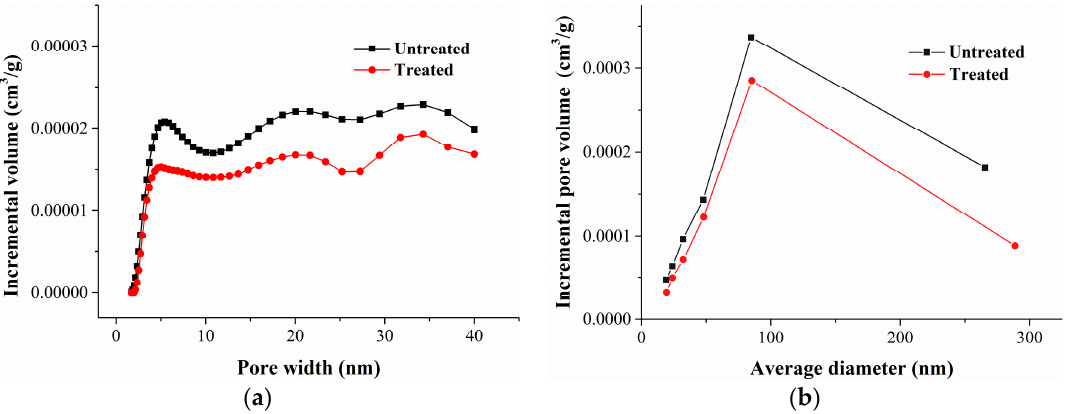
Figure 9. Pore volume distribution of argon adsorption. ( a ) Calculated by the DFT model; and ( b ) Calculated by the BJH model.